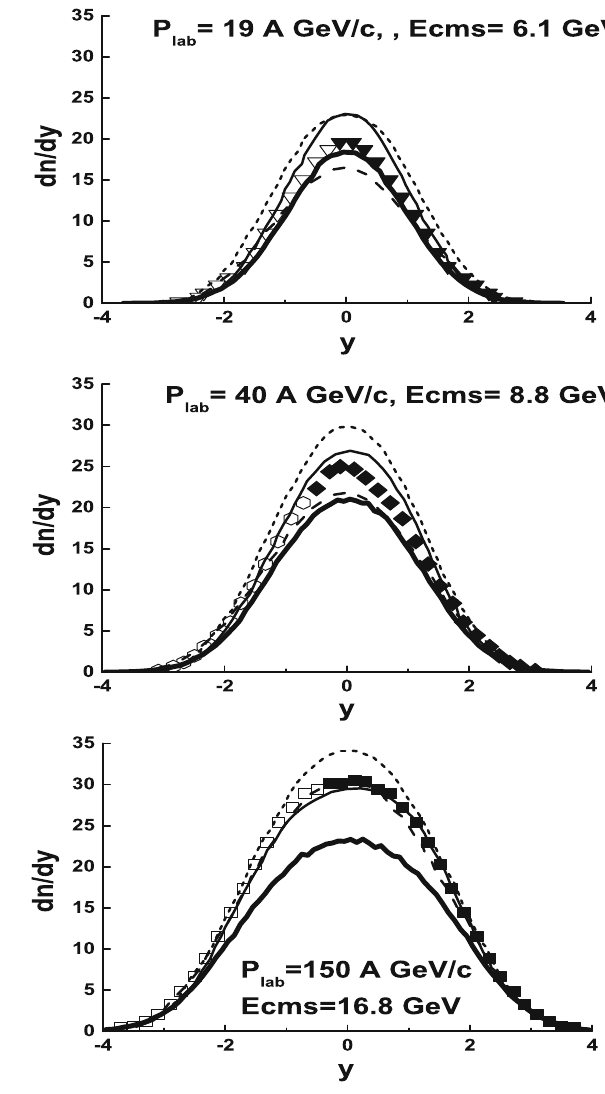
symbol size. The predictions of the EPOS, UrQMD and HIJING mod- els obtained by the collaboration [1] are shown by thin solid, long and short dashed lines, respectively. The FTF model results are shown by thick solid